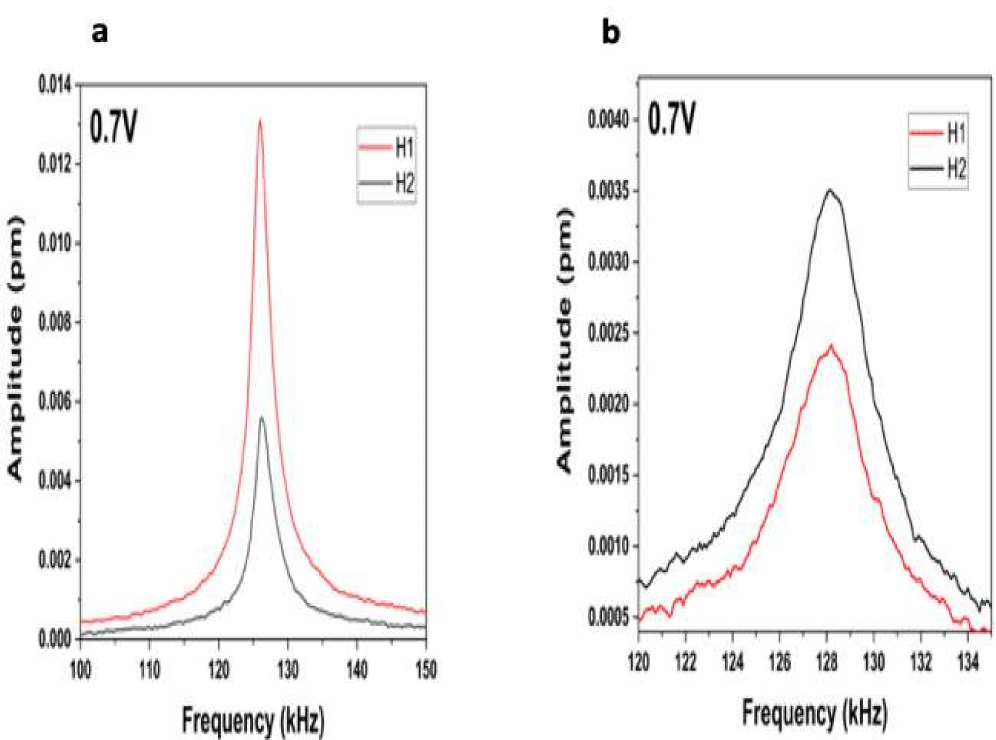
Figure 4. Comparative response of the first and second harmonic for the sweep of frequencies with a voltage of 0.7 V for ( a ) Monoclinic HAP and ( b ) Hexagonal